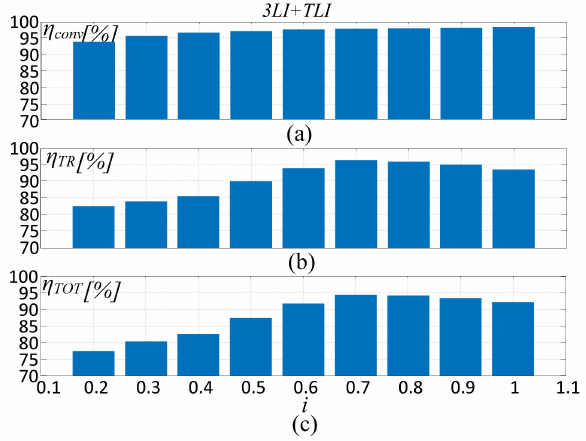
Figure 20. Efficiency vs. load current. ( a ) Three-level inverter (3LI) + TLI efficiency. ( b ) Transformer efficiency. ( c ) Total